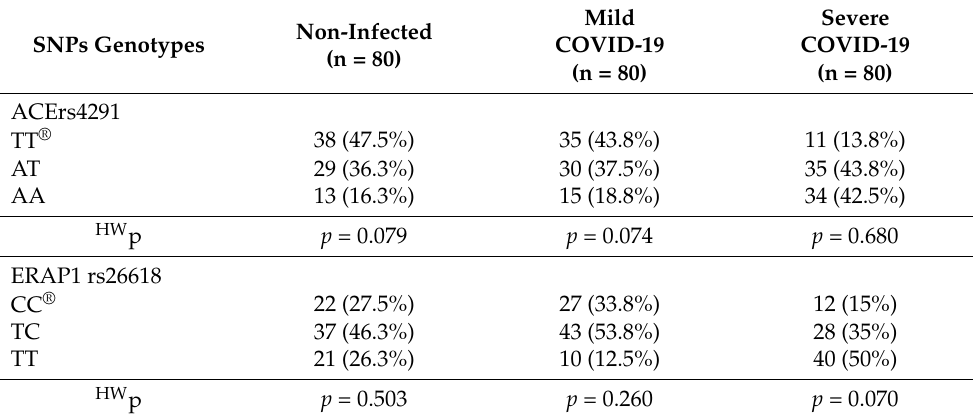
Table 2. Hardy–Weinberg for different SNPs in each